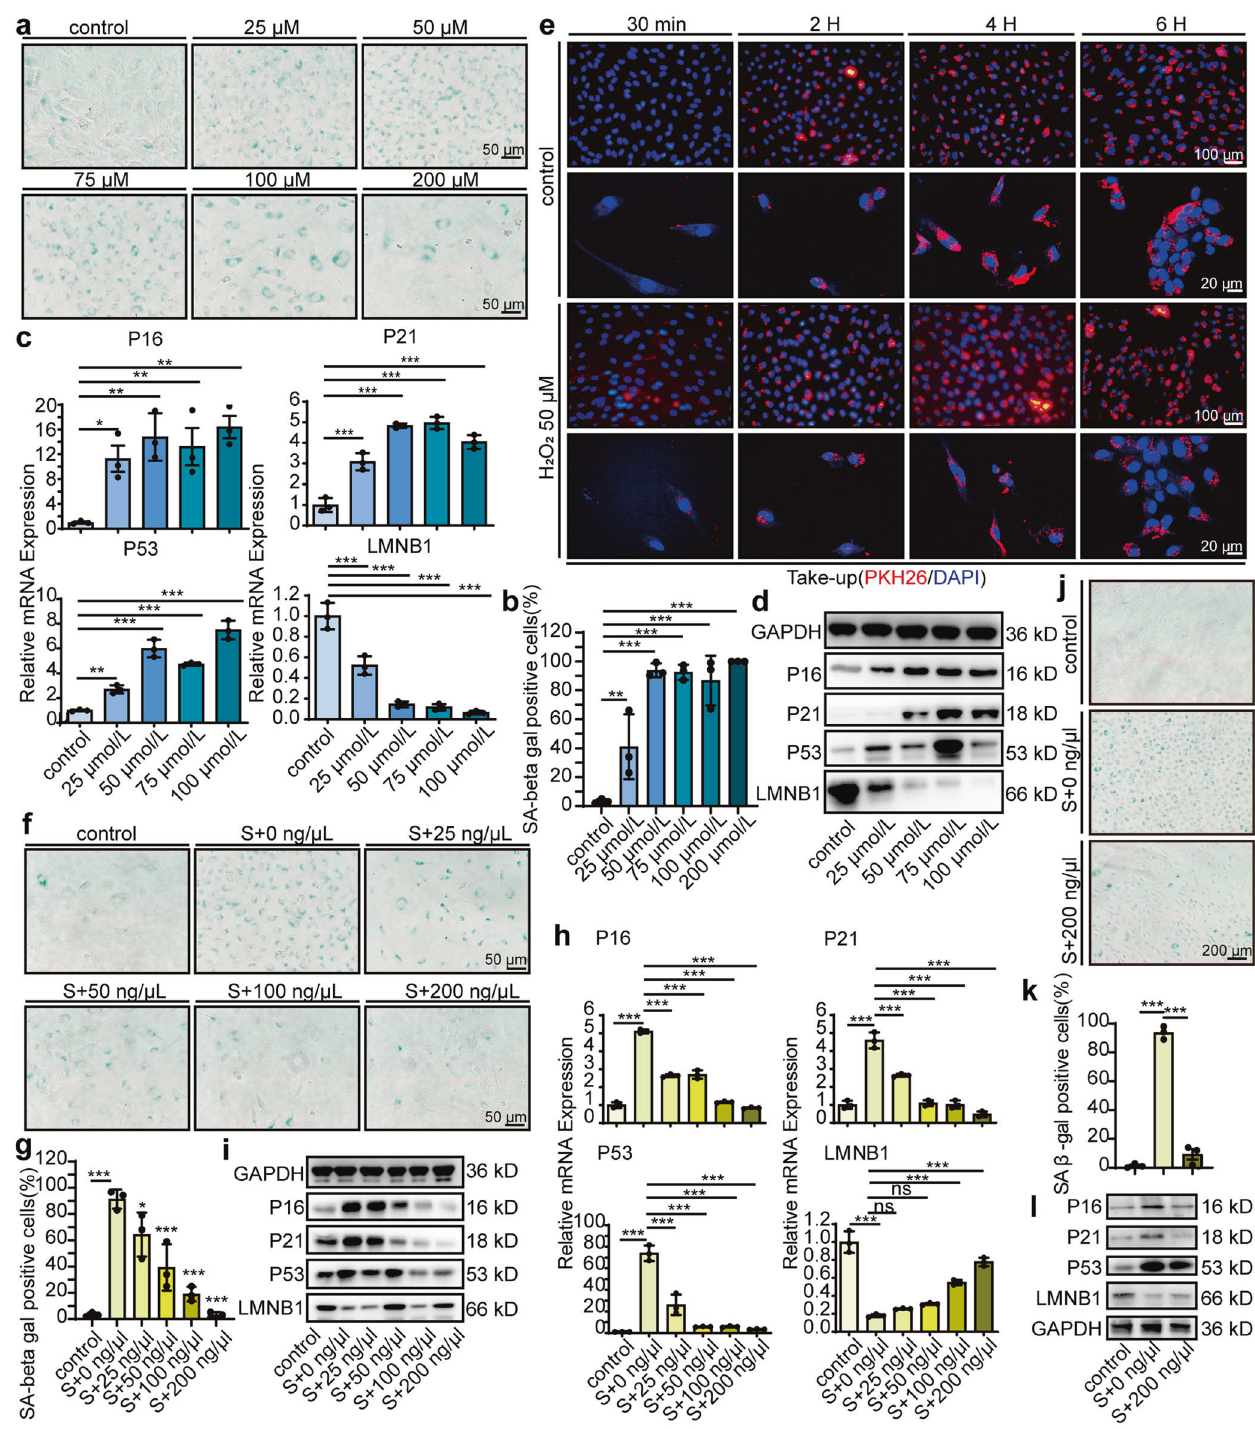
Fig. 2 d Representative images of western blot analysis showing the senescence markers P16, P21, P53, and LMNB1 in HUVEC after 48 hours of 2 h pre-treatment with different concentrations of H 2 O 2 (25 μ mol/L, 50 μ mol/L, 75 μ mol/L, 100 μ mol/L). f . Representative images of SA β -gal staining in HUVECs (scale bar, 50 μ m). HUVECs were incubated with 0 ng/ μ L, 25 ng/ μ L, 50 ng/ μ L, 100 ng/ μ L and 200 ng/ μ L MSC-sEV for 48 h after pretreated with H induce senescence and then incubated with PBS (S + 0 ng/ μ L) or 200 ng/ μ L MSC-sEV (S + 200 ng/ μ L) for 48 h. HUVECs cultured in the media with normal glucose 5.5 mM were used as control. Signal Transduction and Targeted Therapy (2022)